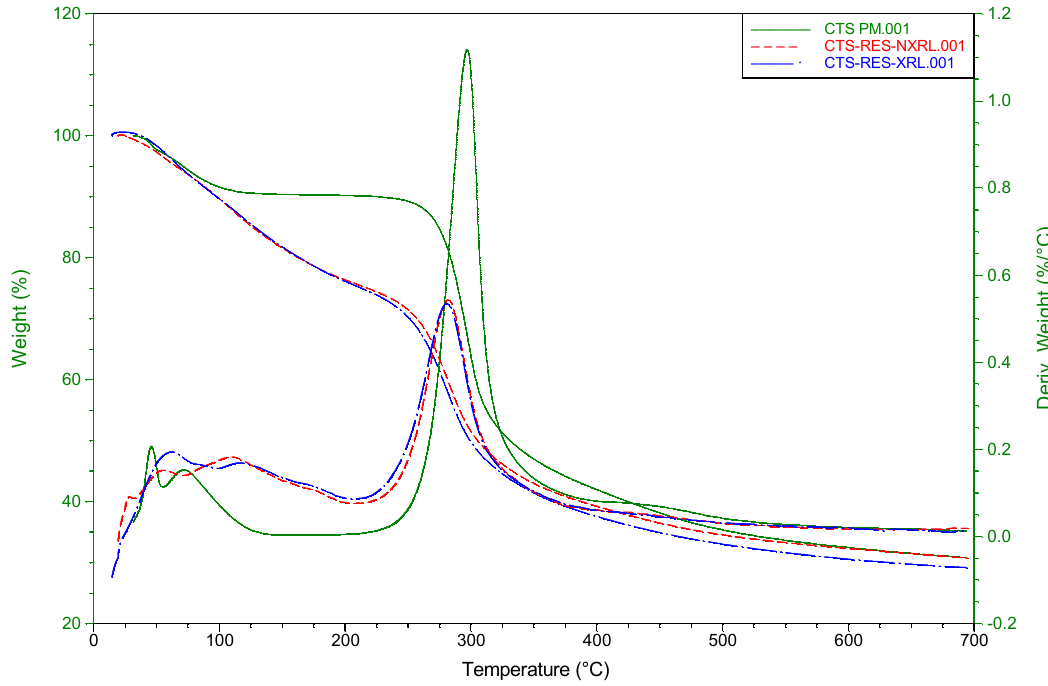
Figure 4. TGA traces of commercial chitosan (solid line) and the two RES-loaded CTS-NP composites.